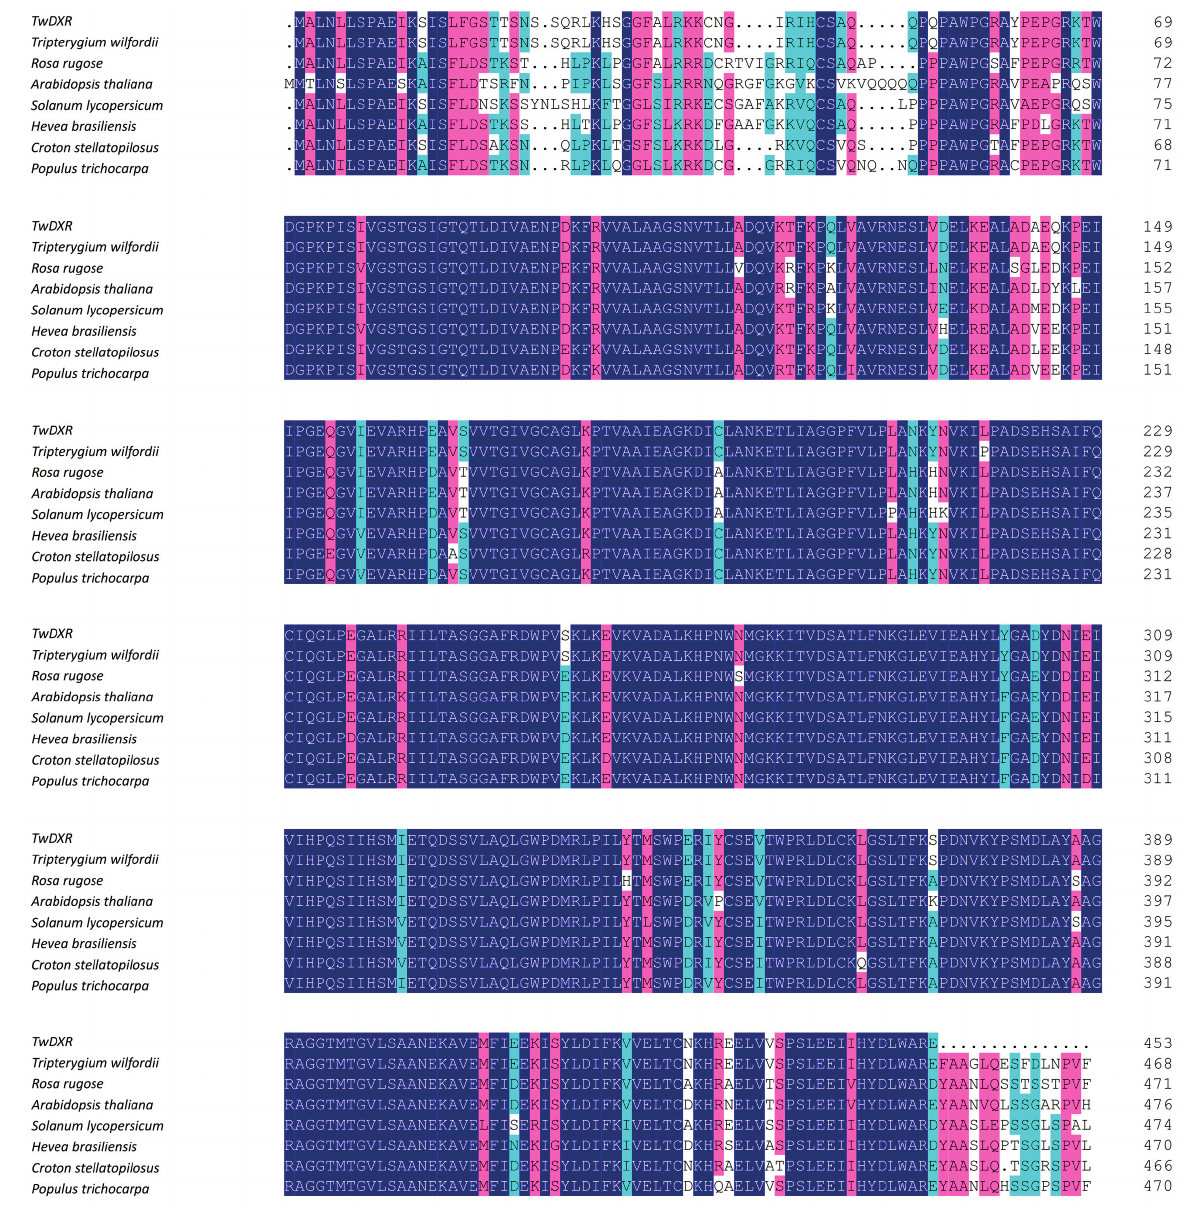
Figure 2. Multiple alignments of TwDXR with other plant DXRs. A multiple alignment of T. wilfordii DXR with the DXR of other plants was analyzed on DNAMAN 8.0 and based on the following protein-sequence data: Tripterygium wilfordii (AHW46302.1), Rosa rugosa (AEZ53171.1), Arabidopsis thaliana (AED97657.1), Solanum lycopersicum (NP_001234553.1), Hevea brasiliensis (ABD92702.1), Croton stellatopilosus (ABO38177.1), and Populus trichocarpa (XP_002318048.2). Dark blue boxes stand for identical residues; pink boxes stand for homologous residues. Dark blue: identity = 100%; red: 75% ≤ identity < 100%; light blue: 50% ≤ identity ≤